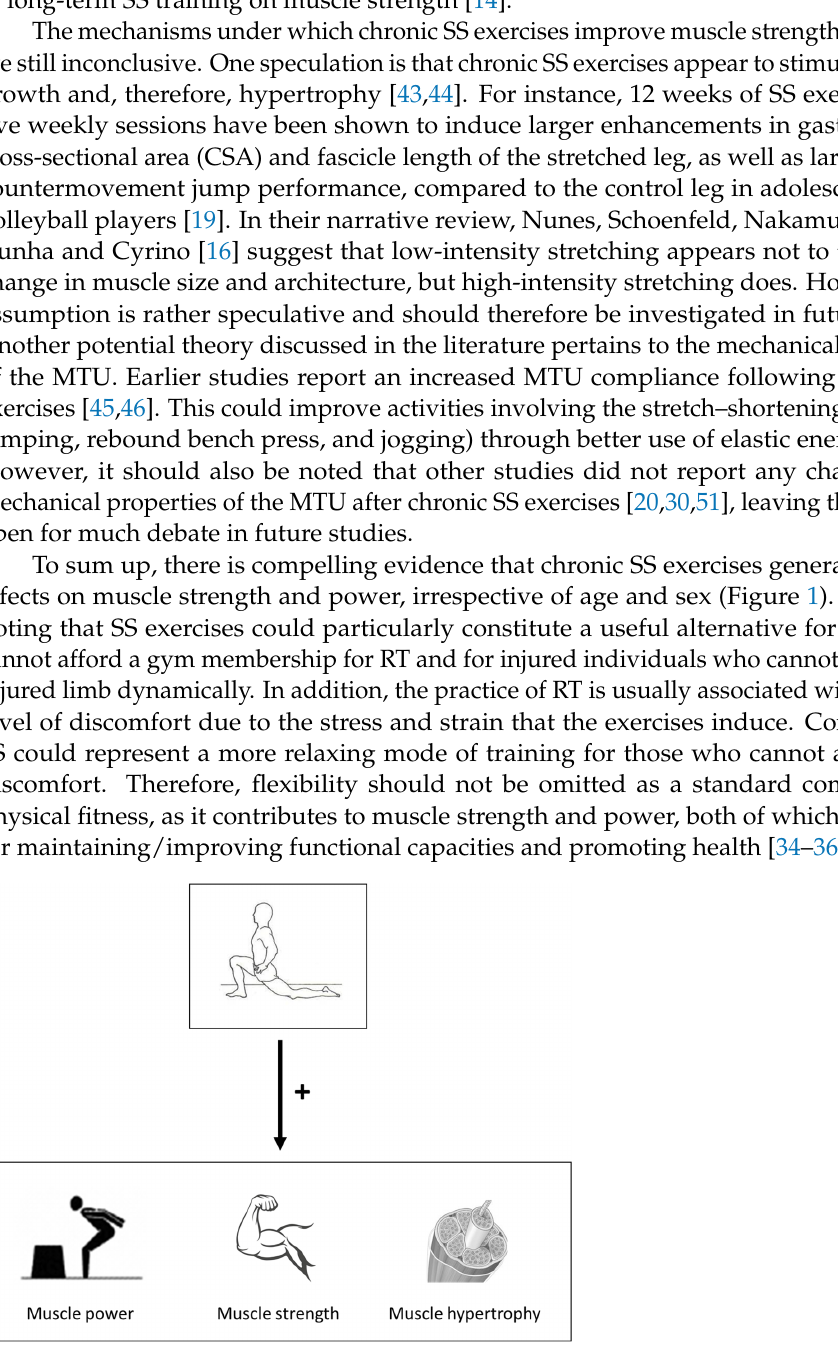
Figure 1. The chronic effects of single-mode static stretching training on muscle strength, muscle power, and muscle hypertrophy. The “+” stands for the positive effects of long-term static stretching training on the muscle strength and power [13,14,23,24,38,39,53] as well as muscle hypertrophy